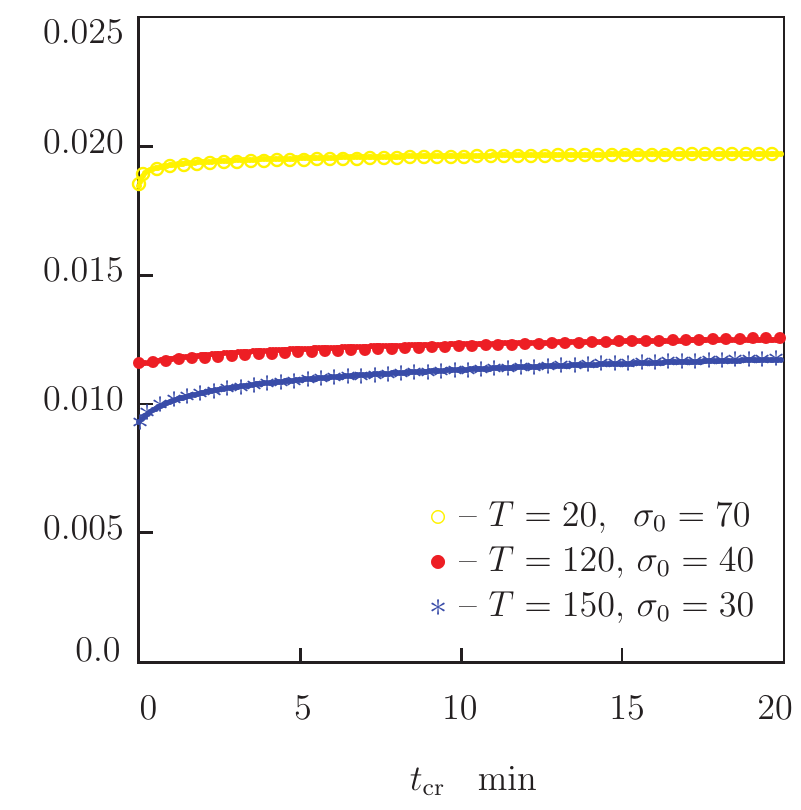
Figure 5. Strain (cid:101) versus creep time t cr . Symbols: experimental data in creep tests with various stresses σ 0 MPa at temperatures T ◦ C. Solid lines: results of